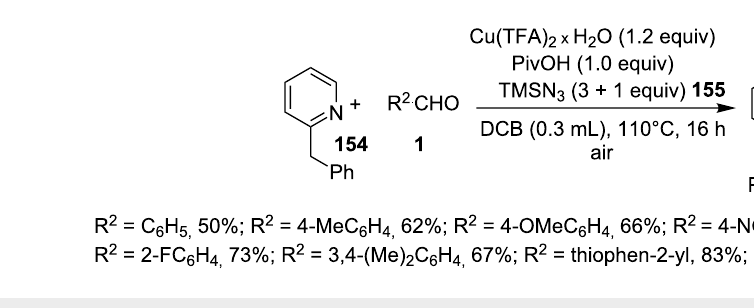
Scheme 56: Cu(II)-promoted C(sp 3 )-H amination reaction.